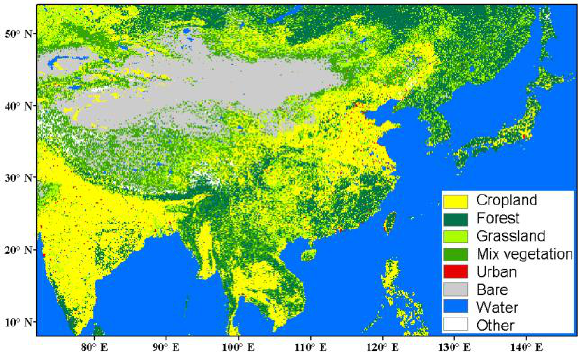
Figure 1. Land cover classification map of East Asia derived from ESA GLC data.